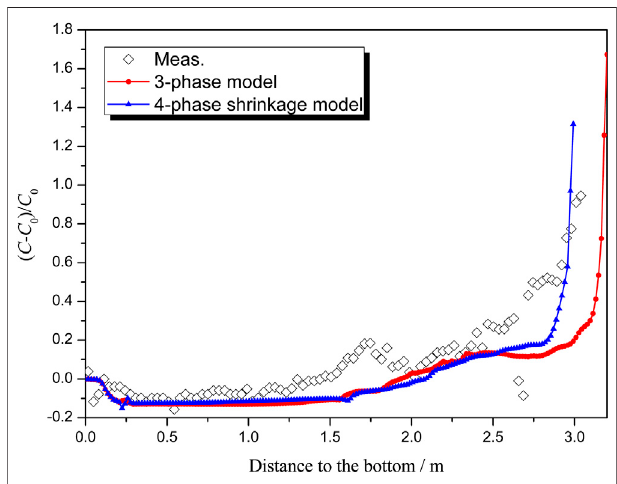
FIGURE 4 | Comparison of segregation index along the centerline of the ingot between experimental results and simulated results of the three-phase model and the four-phase shrinkage